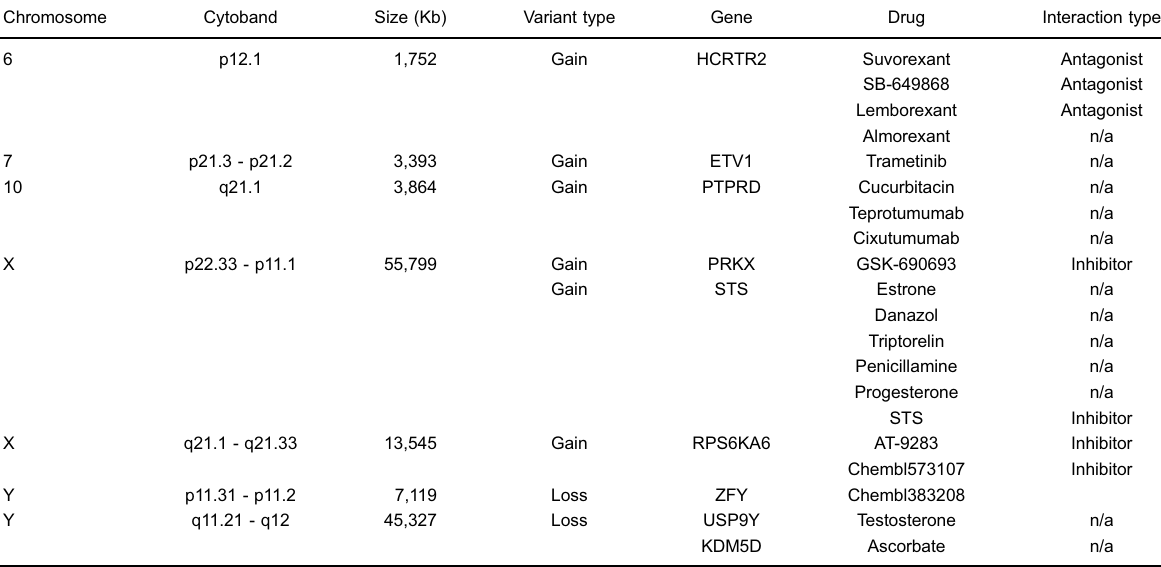
Table 2. Druggable genes of the AHOL1 cell line. Information of each gene regarding their chromosomal location, cytoband, size (kb), type of alteration found (gain or loss), drugs, and the type of interaction of each drug is provided below. Chromosome Cytoband Size (Kb) Variant type Gene Drug Interaction